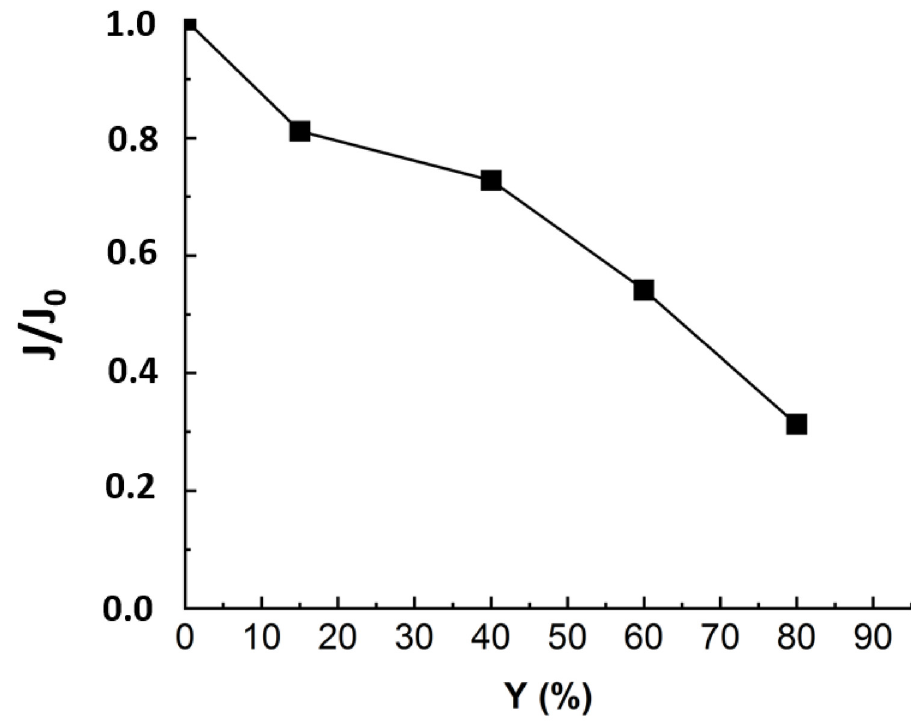
Figure 3. Flux evolution in NF experiment applied to MBR real effluent matrix: TMP = 10